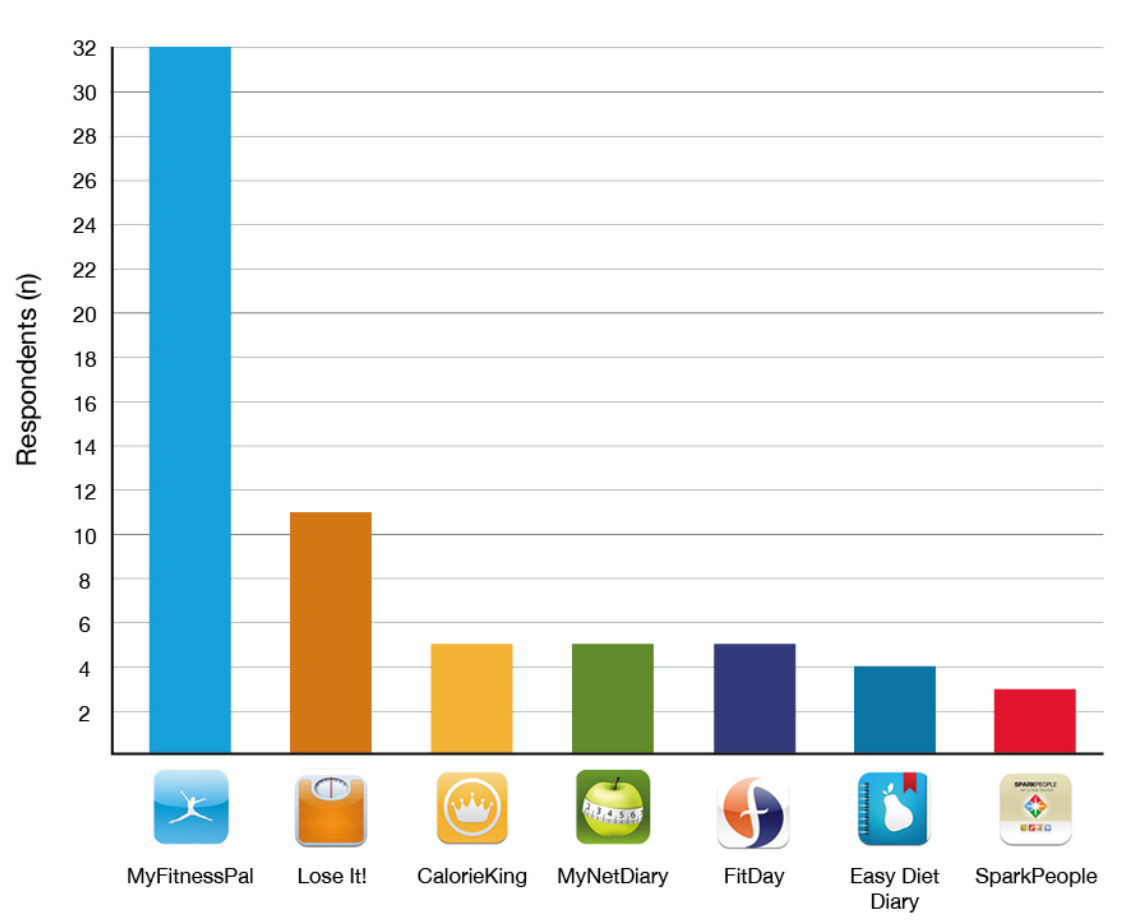
Figure 2. “Which smartphone diet application(s) do you use?”